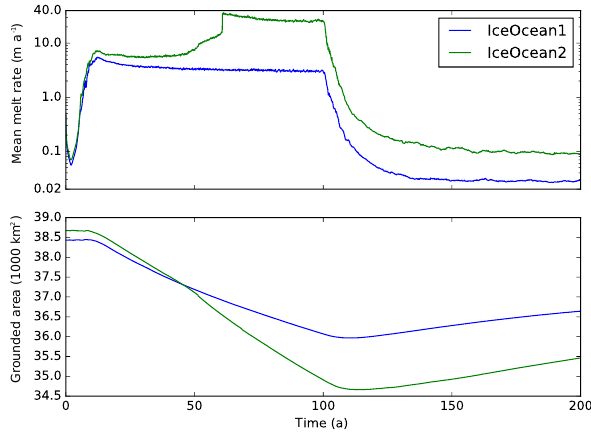
Figure 12. Example results from POPSICLES simulations of IceO- cean1 (no dynamic calving) and IceOcean2 (thickness-based calv- ing criterion) using SSA and the sliding law from Weertman (1974) showing melt rates averaged over the shelf area (top panel) and the grounded area as functions of time (bottom panel). Though melt rates are initially similar, after about year 40 the dynamic calving in IceOcean2 begins to remove substantial areas of the ice shelf (no- tably when an iceberg is removed just after year 60), resulting in larger mean melt rates (but similar total melt fluxes) for that ex- periment. IceOcean2 loses substantially more grounded area than IceOcean1 during retreat (the first 100 years), presumably due to a loss of buttressing from the ice shelf, which has nearly completely calved away. The grounding line re-advances at approximately the same rate in both experiments because the advancing shelf it thick enough not to